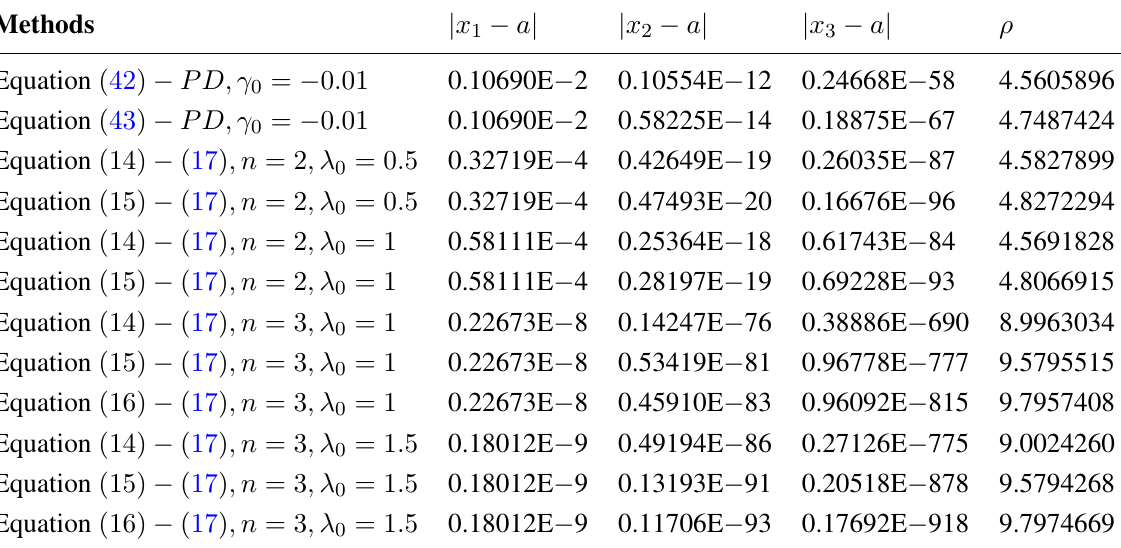
( x ) by the methods with 1